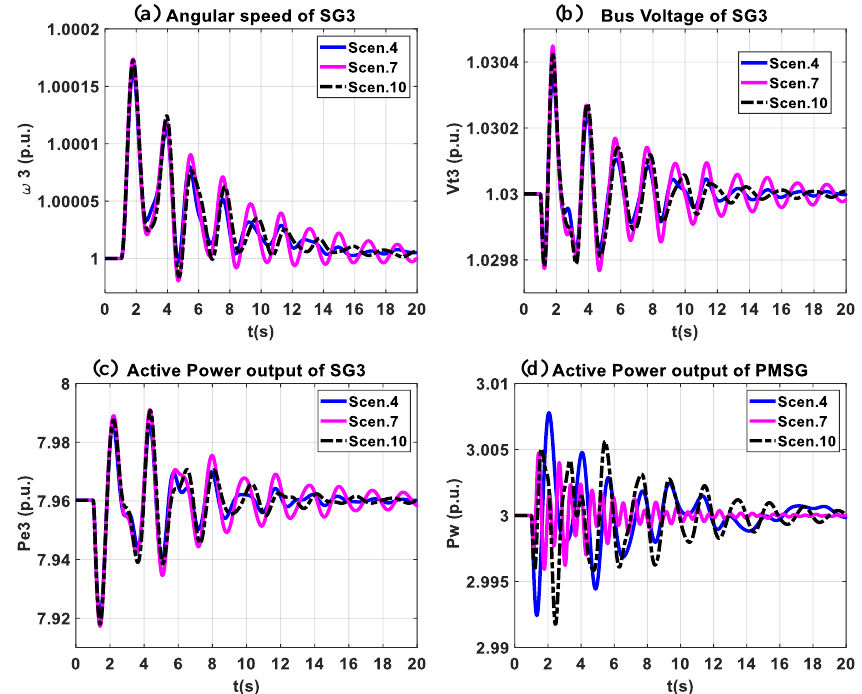
Figure 13. The dynamic responses of interaction between FCWG dynamics and electromechanical dynamics: ( a ) angular speed of SG3; ( b ) bus voltage of SG3; ( c ) active power of SG3; ( d ) active power of FCWG.